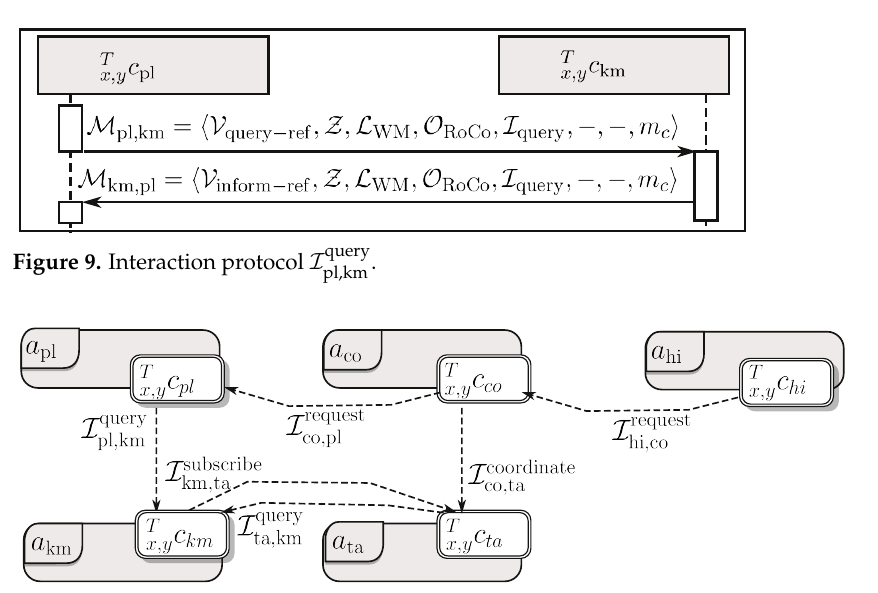
Figure 10. The considered part of Robot Companion realised as five agents: a ta , a km , a co , a hi , and a pl , including interaction protocols. The group a g ex is not